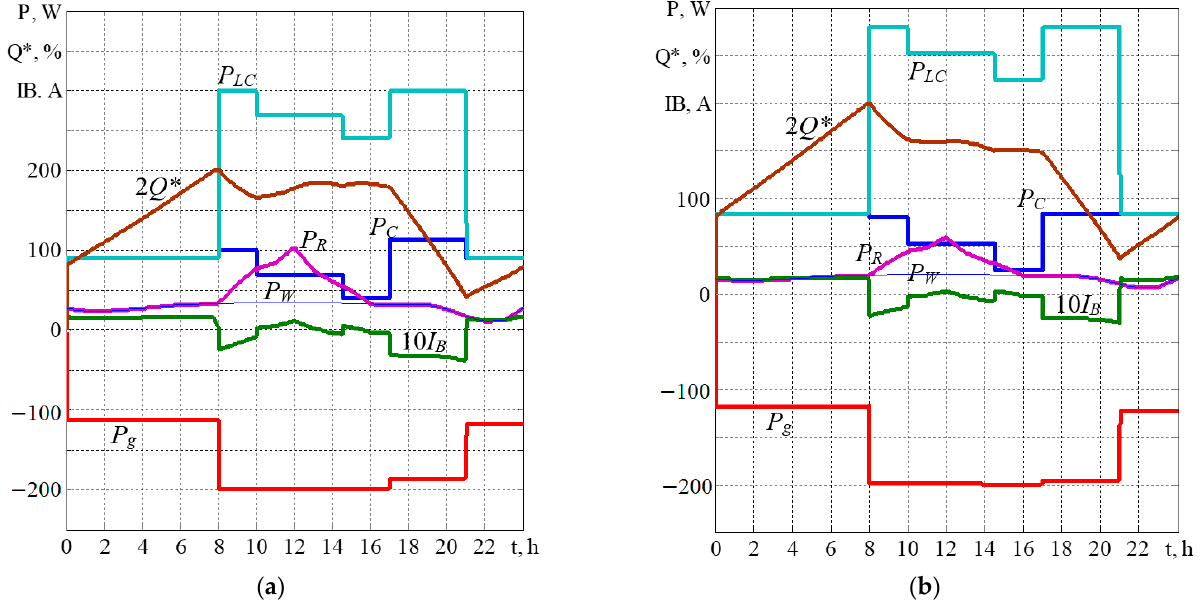
Figure 4. Oscillograms for December Day at: ( a ) at a decrease W R /2 and ρ = 1.5; ( b ) at a decrease W R /3.5 and ρ = 1.4 ( P LC , load power; P C , load added power; P R , the actual power of RES; P g , power consumed from the grid; P W , WG power; I B , battery current; Q* , battery state of charge). The oscillograms for June Day (30 June 2013) at different values of P C 23 and P LC = P LCR are presented in Figure 5a; at P C 23 = 120 W ( k E = 2.496, ρ = 1.6) in Figure 5b; at P C 23 = 200 W ( k E = 2.588, ρ = 1.6) in Figure 5c; at P LC = 320 ≥ ( P C 23 = P R 23 ) ≥ P 1 C 23 = 120 ( k E = 2.984, ρ = 1.6). Due to an increase in the degree of discharge of the SB at the interval ( t 2 , t 3 ), the value Q* 2 has to increase (discharge from 43% to 34%). At the same time, there is no significant improvement in the use of renewable energy. In the case of Figure 5c, there is almost complete use of RES energy.